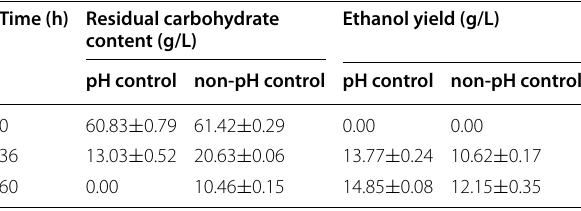
Table 4 Effect of pH on carbohydrate